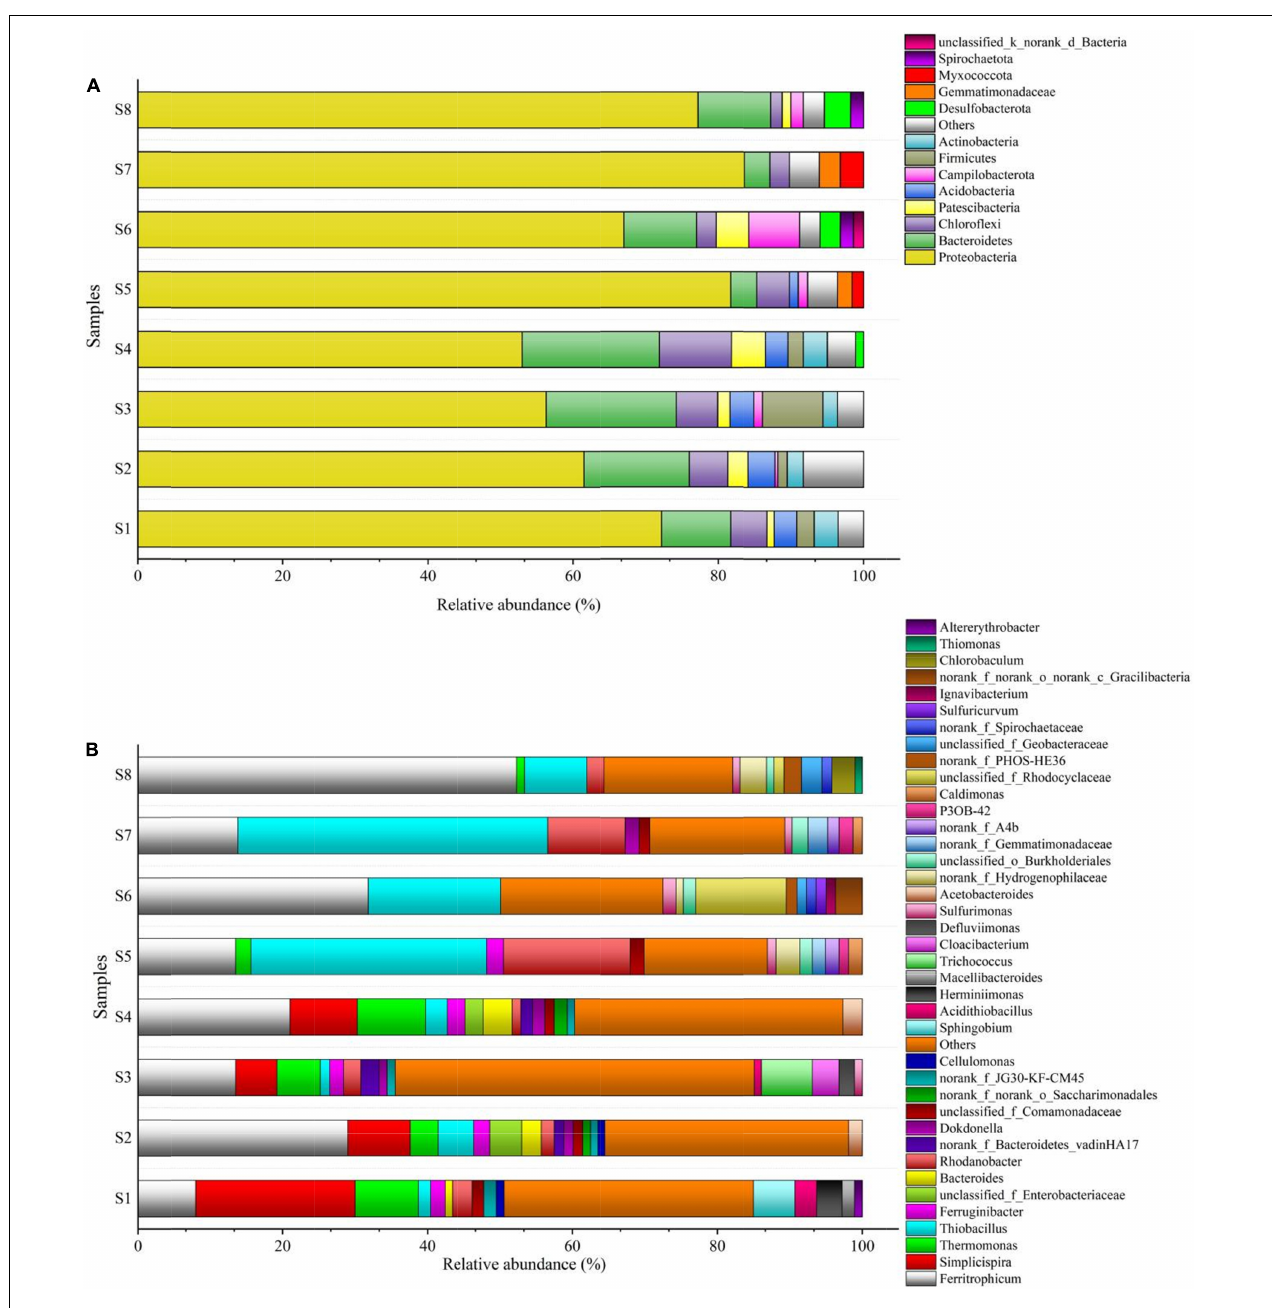
FIGURE 5 | Taxonomic classification of the eight bio-samples at (A) phylum level; (B) genus